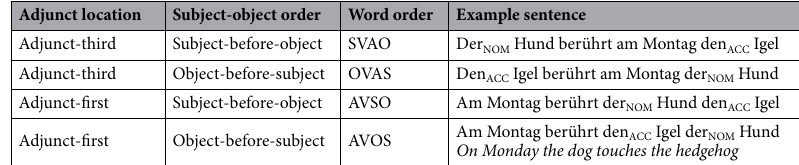
Table 1. Example sentences in each of the four sentence conditions (S = Subject, V = Verb, A = Adjunct, O = Object).